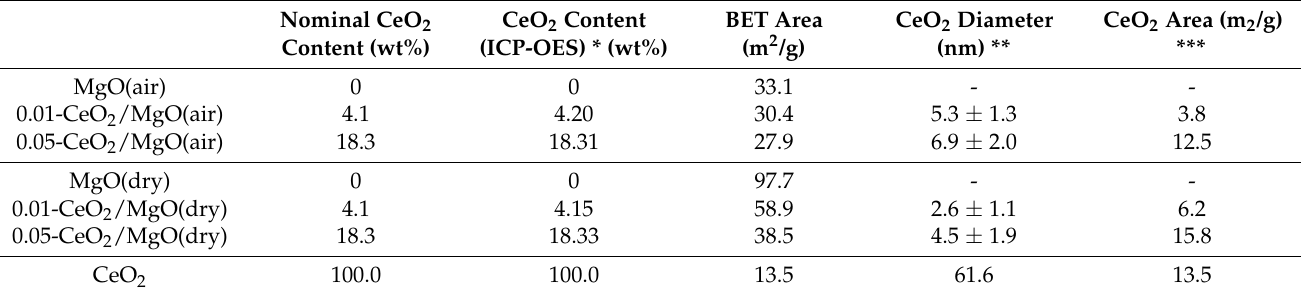
Table 1. Morphological properties of the prepared